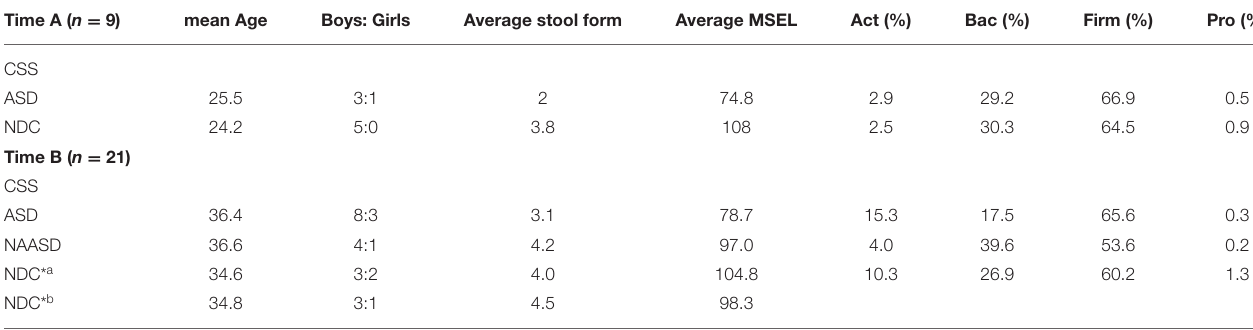
TABLE 2 | Description of child and microbiome characteristics at time points A and B, and per diagnosis category. Time A ( n = 9) mean Age Boys: